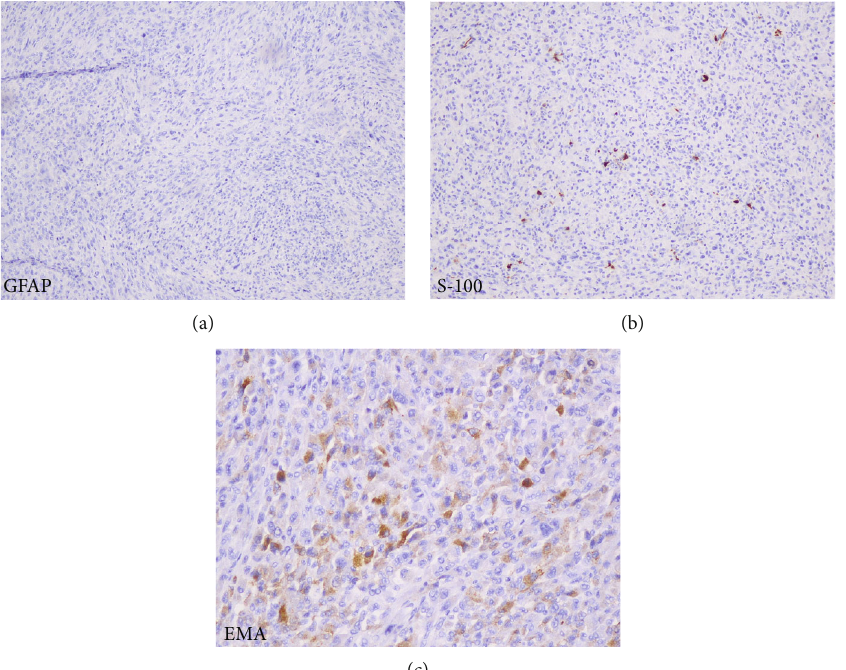
Figure 3: Dural-based high-grade sarcoma without di ff erentiating features. (a) Representative image of GFAP stain showing no features of a glial neoplasm. (b) Representative image of a positive S100 staining indicative of a stromal tumor. (c) Representative image of EMA stain, suggestive of epithelial characteristics of the